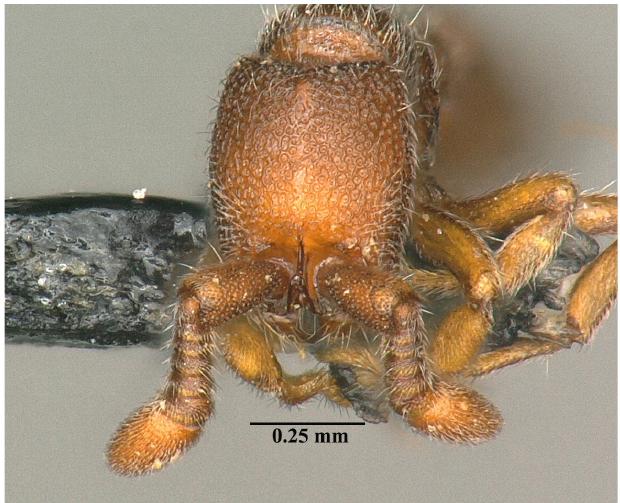
Fig 1 . Ooceraea octoantenna Zhou & Chen sp. nov., worker, head in full-face view .